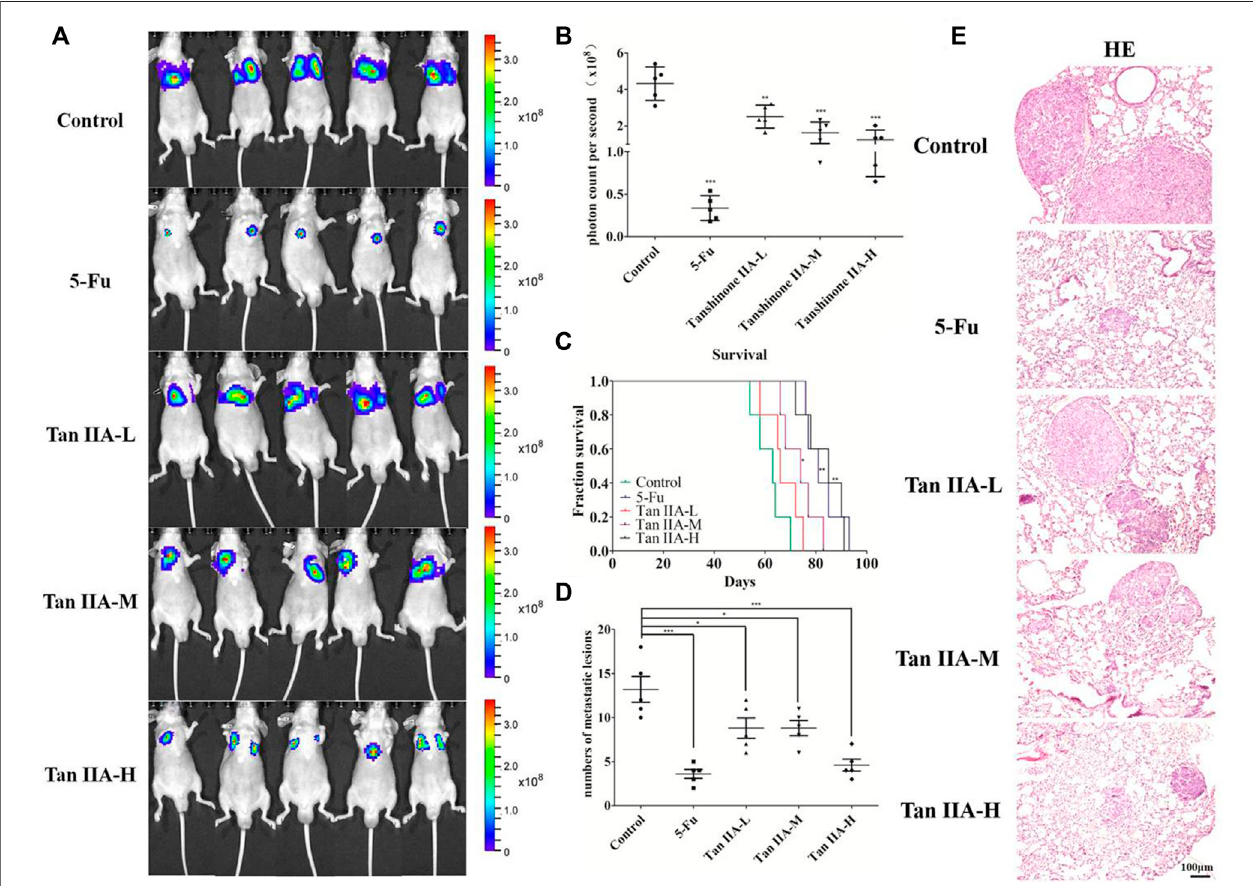
FIGURE 1 | Tan IIA inhibited the metastasis of colorectal cancer in vivo . (A,B) Each group of mice was injected with HCT-116/luc cells through the tail vein. After treatment with Tan IIA at concentrations of 0.5, 1, and 2 mg/kg for 4 weeks, luciferase imaging data was collected by IVIS Lumina system. *** p < 0.001, compared with control group. (C) The survival of tumor-bearing mice were evaluated, * p < 0.05; ** p < 0.01; *** p < 0.001, compared with control group. (D,E) The lung tumors were excised,hemaoxylin-eosin (H,E) stainingwasperformedandthenumberofmetastaticlesionswerecounted,* p < 0.05;*** p < 0.001,comparedwithcontrolgroup.